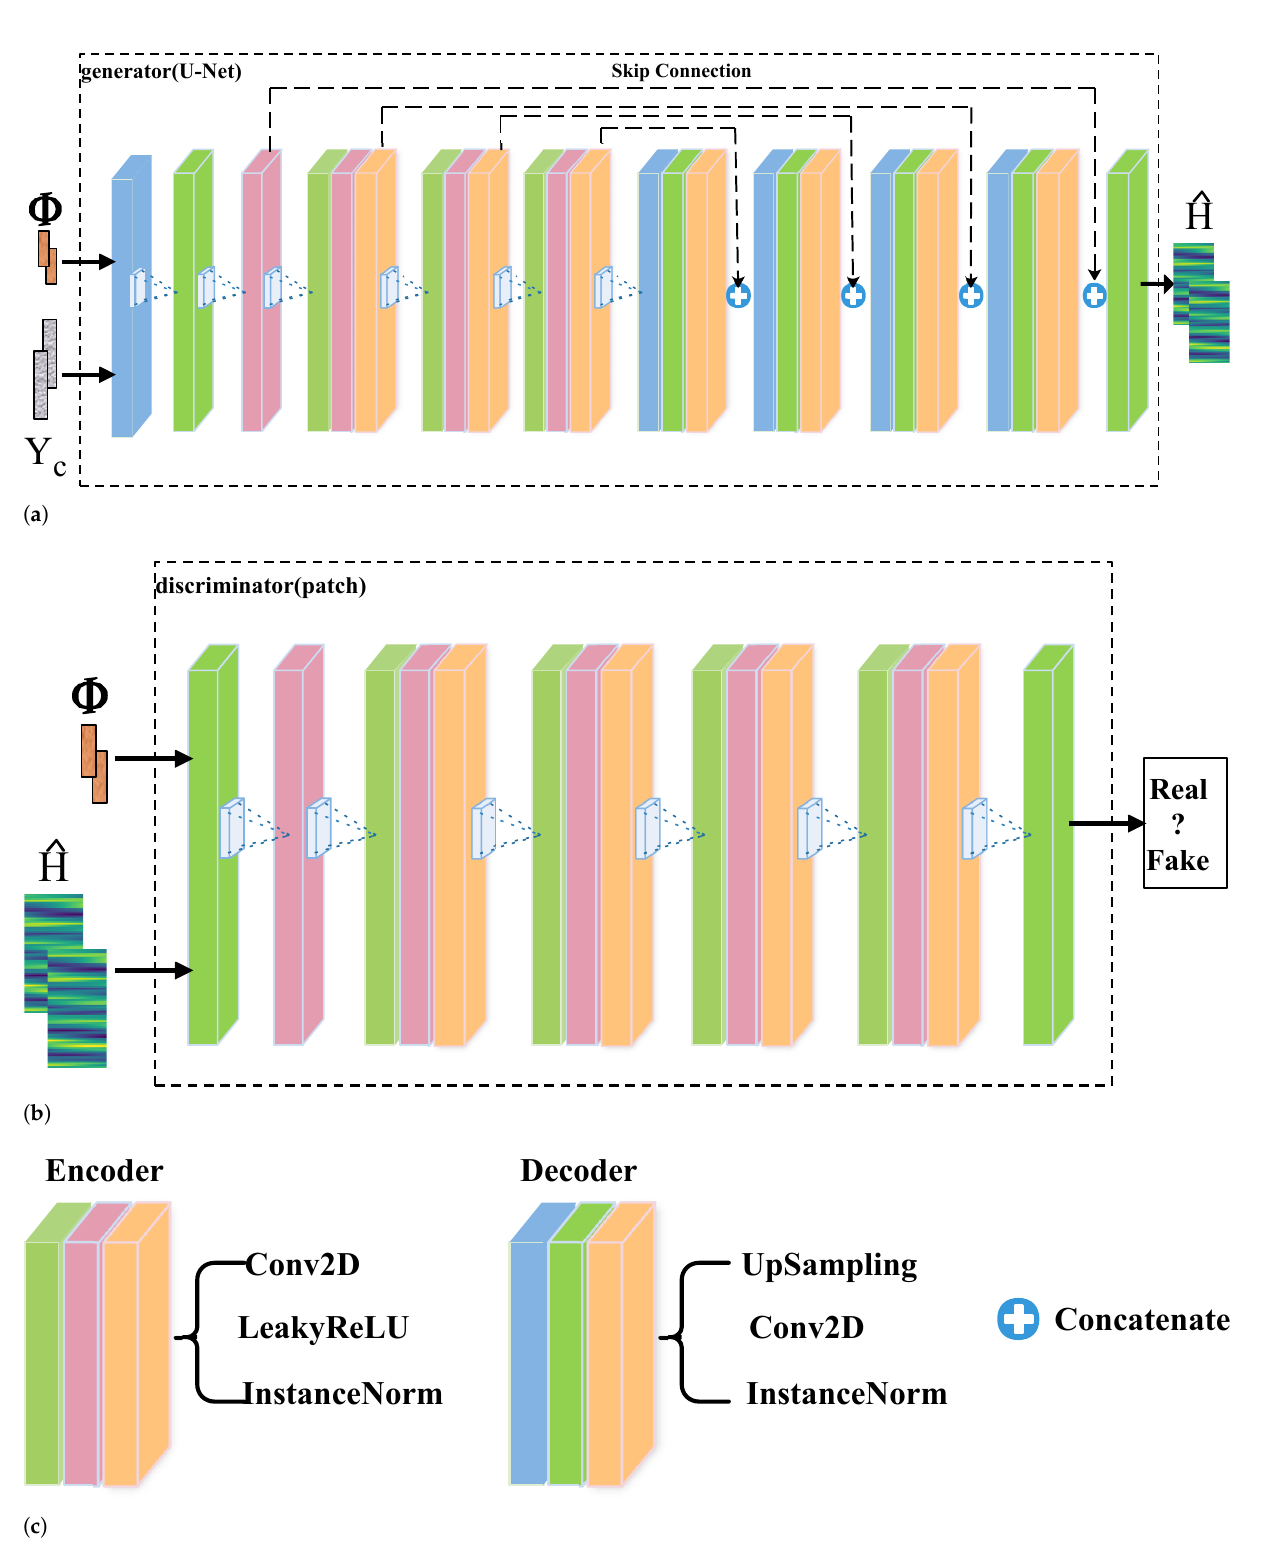
Figure 4. The structure of the proposed cGAN. ( a ) Framework of the generator. ( b ) Framework of the discriminator. ( c ) Composition of the